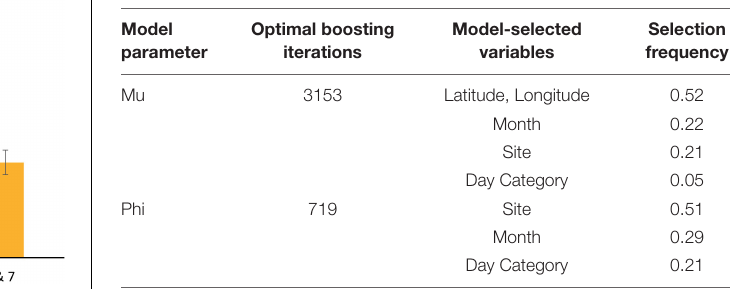
TABLE 3 | Variables selected in the boosted generalized additive model (boosted